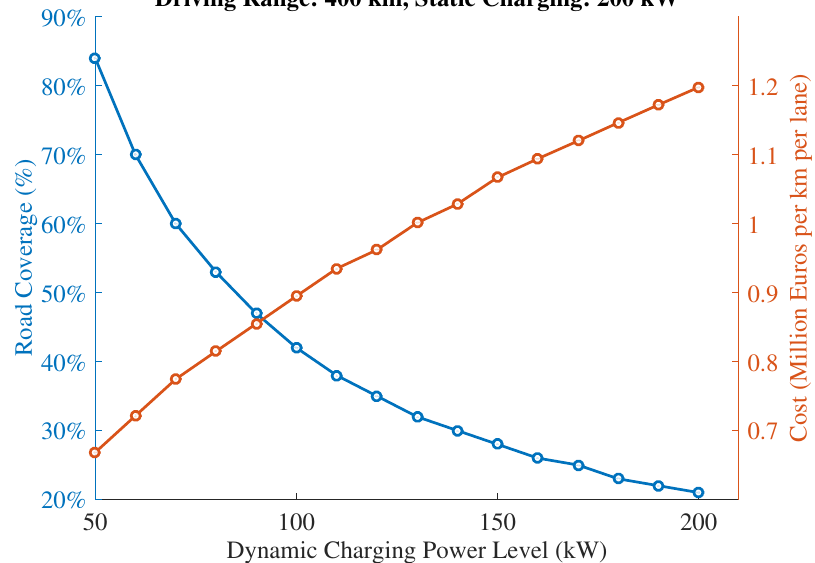
Figure 10. Percentage of road coverage for different dynamic charging power